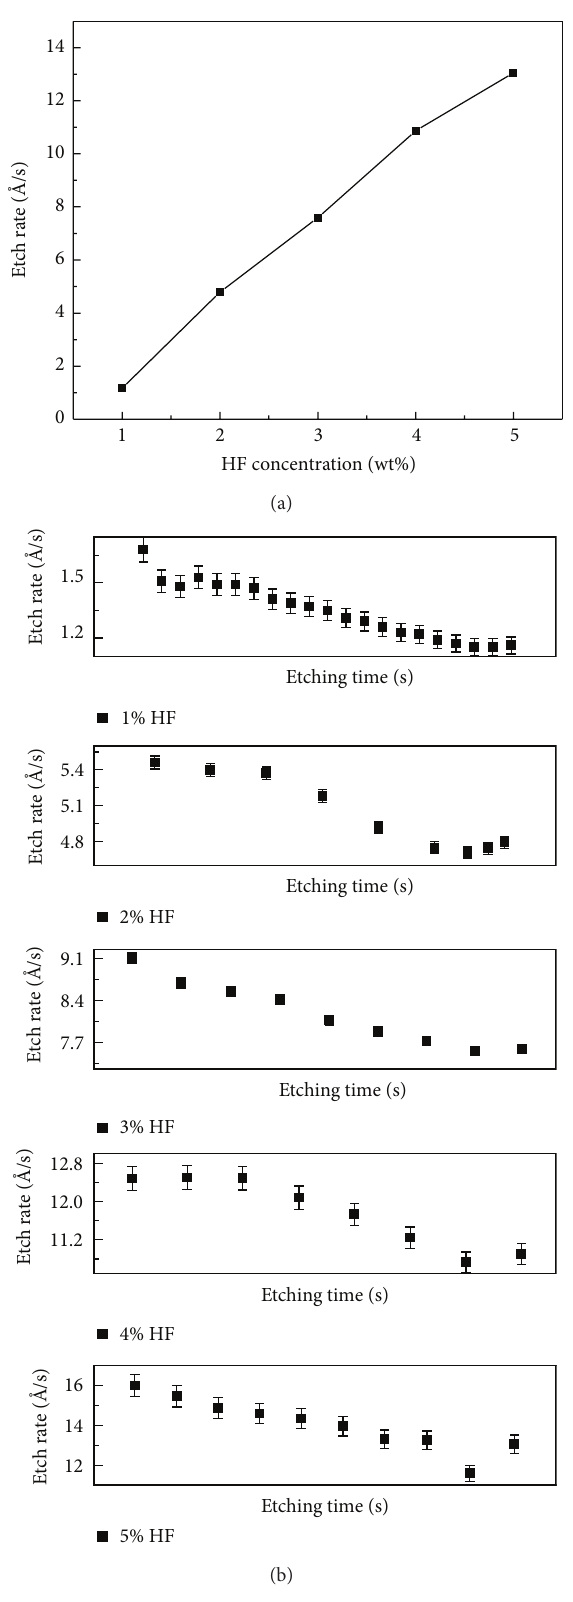
Figure 7: (a) Effect of HF concentration on the etch rate of oxides. (b) Etch rate versus time in different HF concentration for the oxide films grown at 8mA/cm 2 current density and 0.7 vol% of